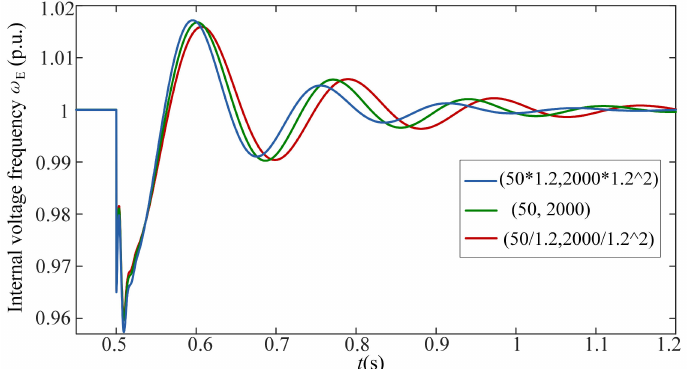
Figure 16. VSC internal voltage frequency dynamics with varied PLL controller parameters ( k p4 , k i4